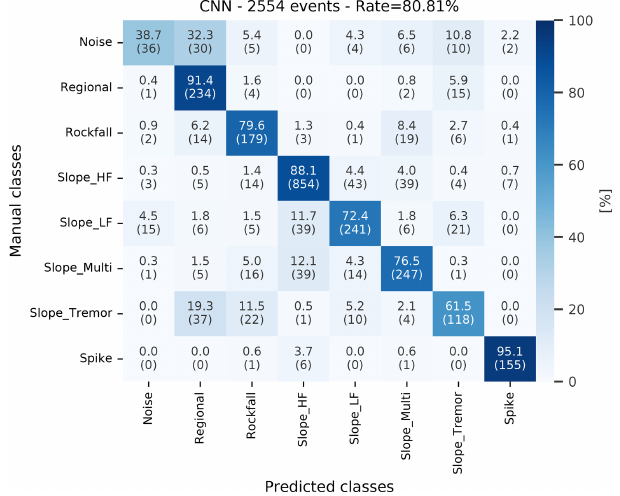
Figure 5. Confusion matrix comparing the results of manual and automatic classification for the test dataset. The matrix is colour- coded by percentage rates. Numbers in brackets indicate the abso- lute number of events in each